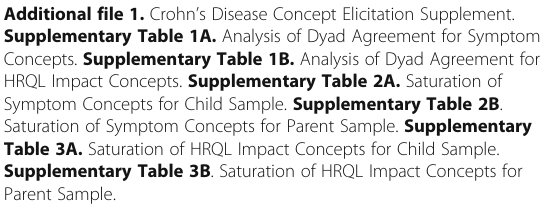
Table 3A. Saturation of HRQL Impact Concepts for Child Sample. Supplementary Table 3B . Saturation of HRQL Impact Concepts for Parent